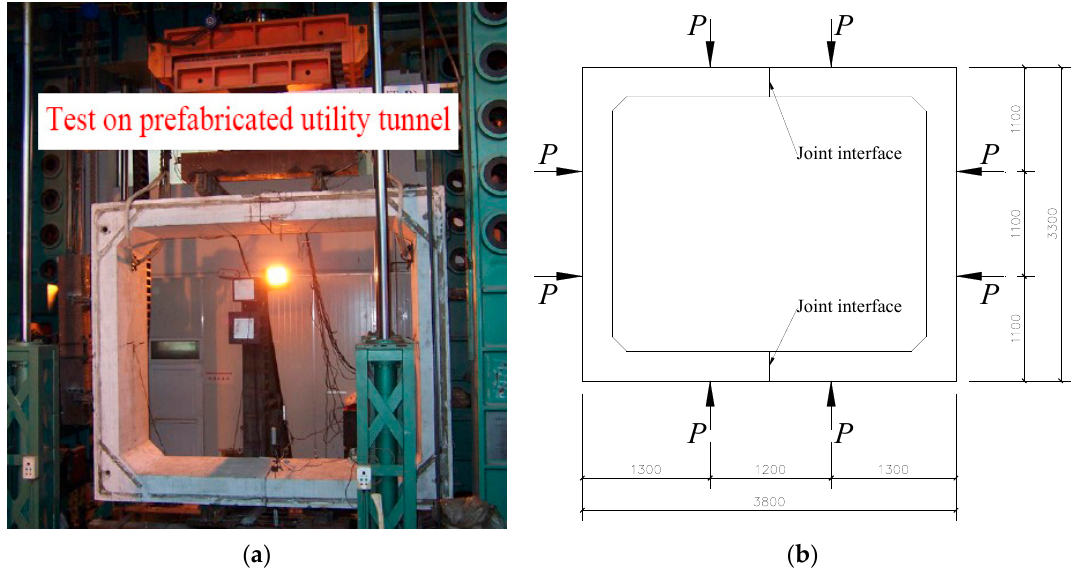
Figure 10. Experimental test setup: ( a ) actual setup and ( b ) schematic setup.